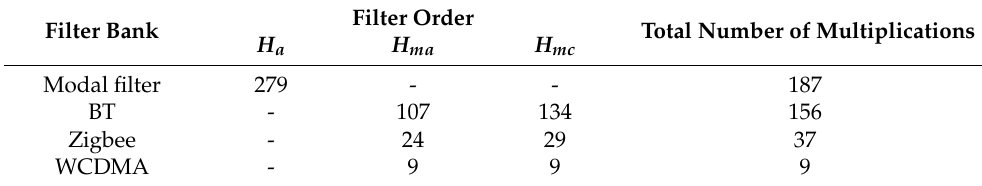
Figure 9. Magnitude response for the WCDMA masking filter using the HFarrow algorithm. Table 6. Multiplication complexity for non-uniform filter bank.